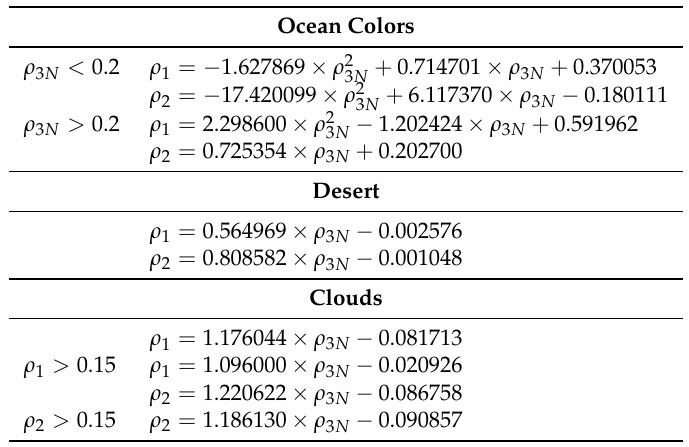
Table 1. Polynomial expansions for the saturation correction of bands ρ 1 (0.56µm), ρ 2 (0.66µm) using ρ 3 N (0.81µm).